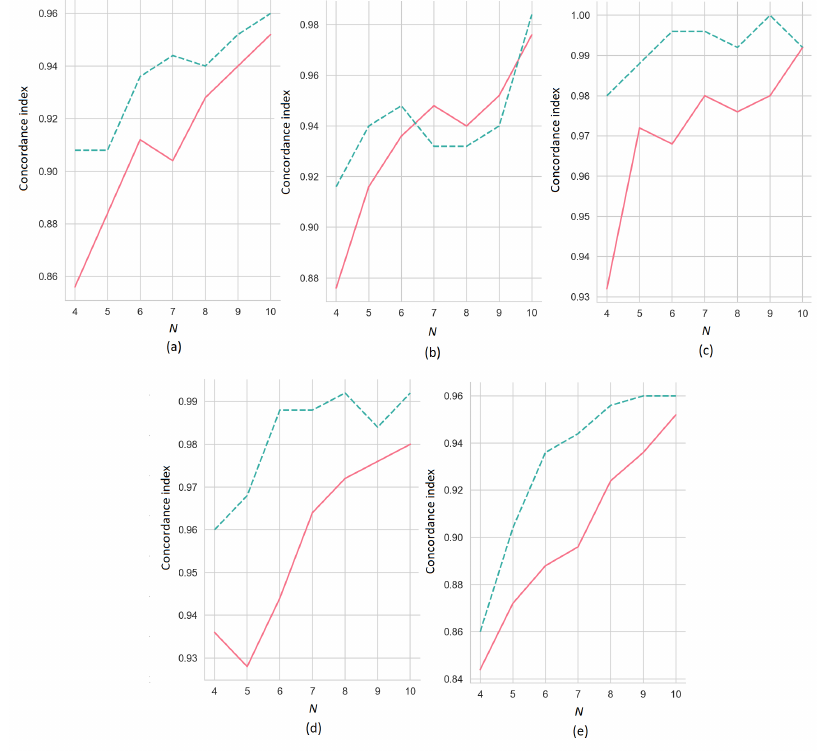
Figure 5. Concordance indices of ER-SHAP as functions of the number of iterations N for t = 2 (the solid line) and 3 (the dashed line) for trained SVMs and five datasets depicted in corresponding Figure